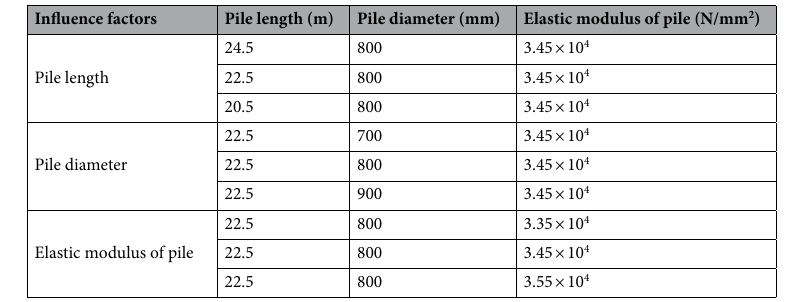
Table 4. Calculation conditions.